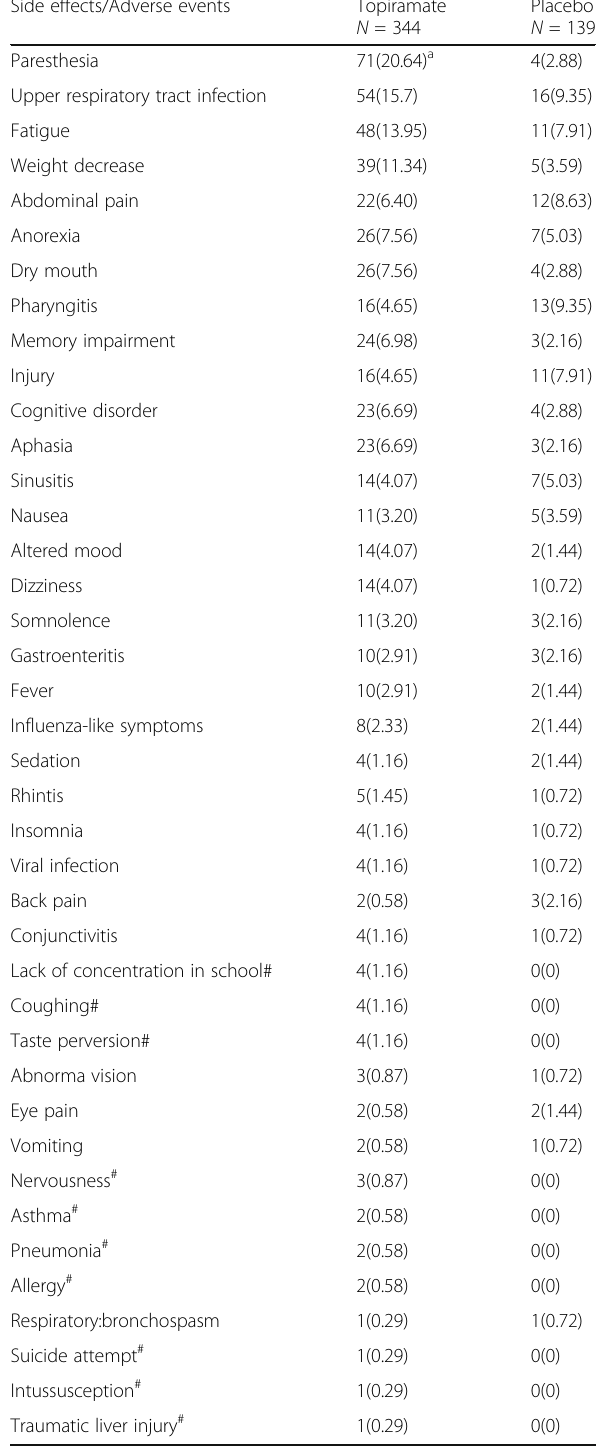
Table 3 Side effects/Adverse events occurring in any group and ranked by overall